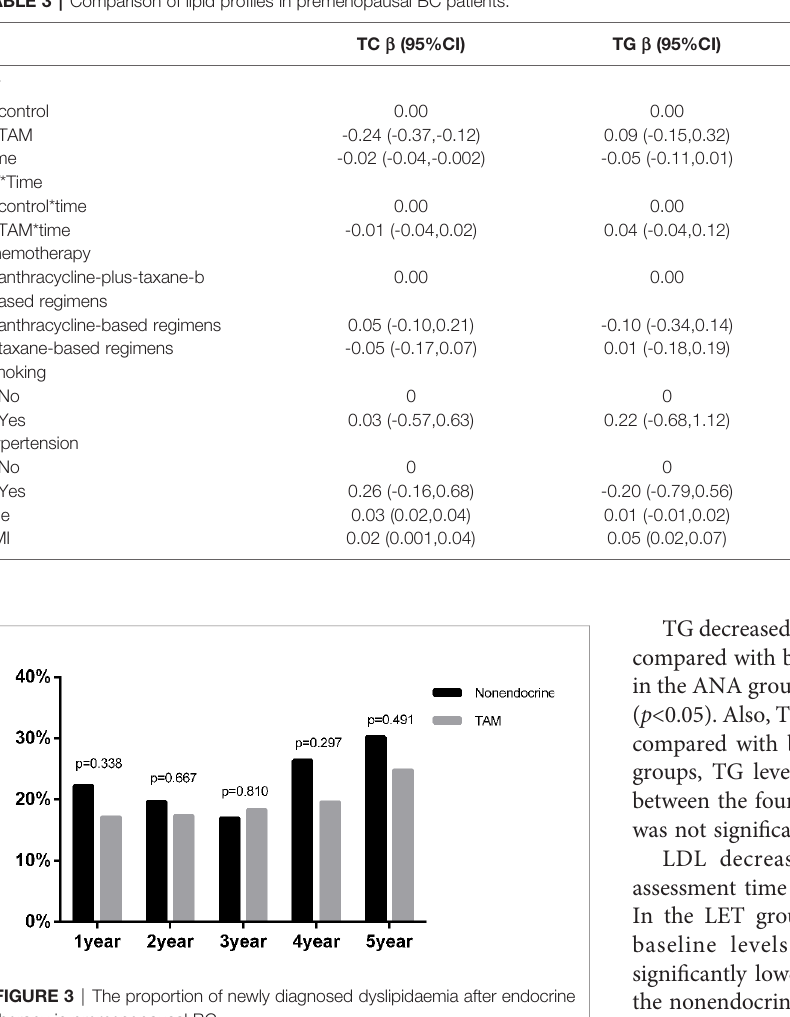
Frontiers in Oncology |